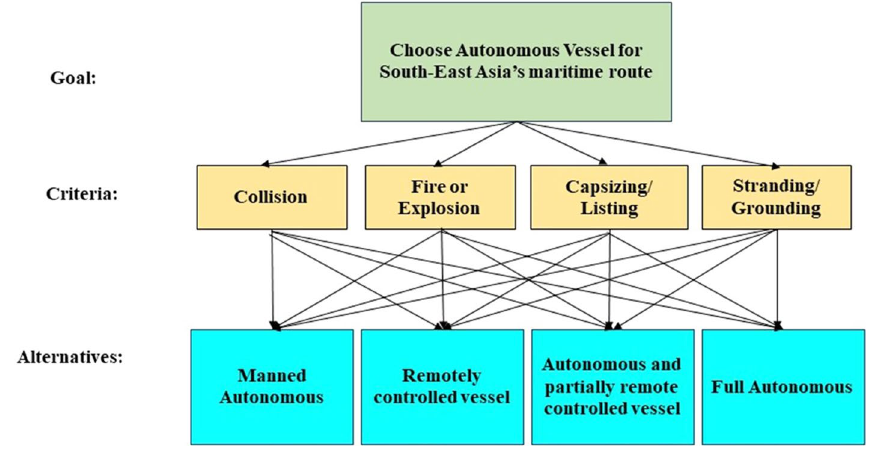
Fig. 6 AHP-MCDA application